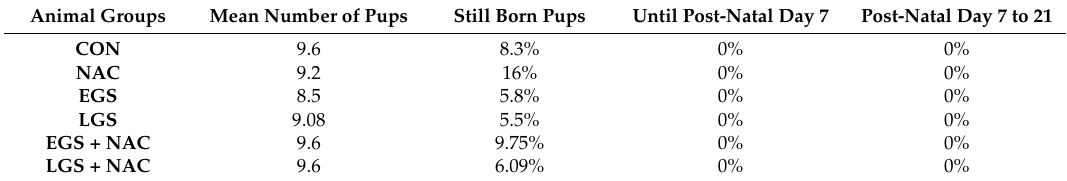
Table 2. Effect of early or late gestational stress and prenatal NAC treatment on the mortality rate. Animal Groups Mean Number of Pups Still Born Pups Until Post-Natal Day 7 Post-Natal Day 7 to 21 CON 9.6